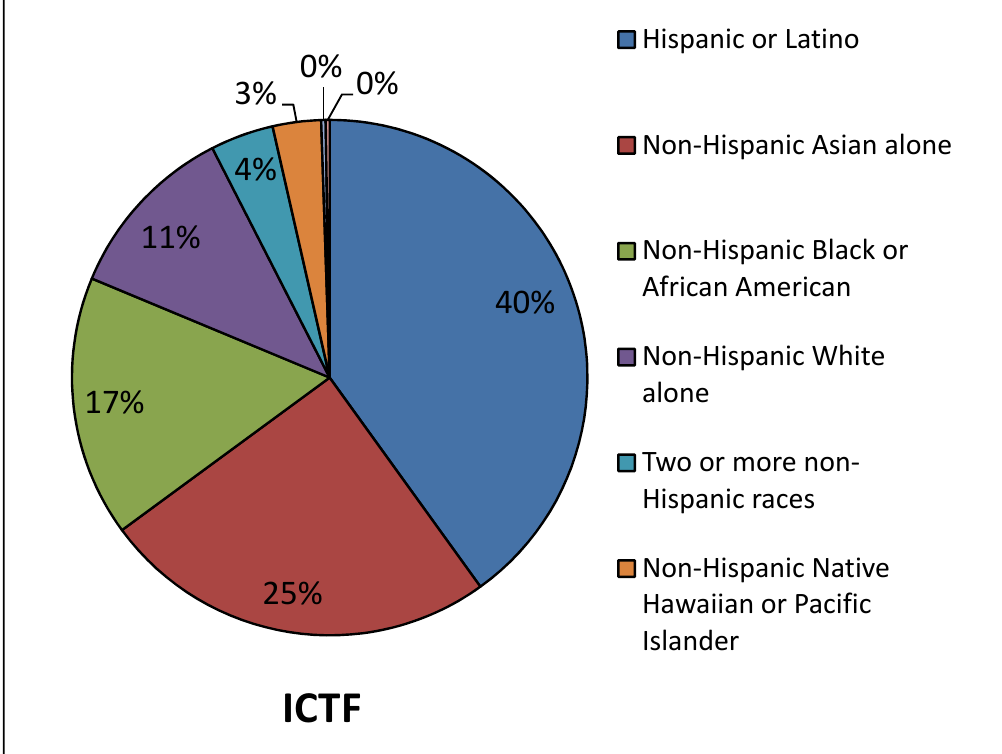
Figure 8. Demographics of the population in west Long Beach in close proximity to the ICTF rail yard, 2000 Census data and in Los Angeles County as a whole at the time that the railroad announced that it wanted to double its capacity; 2000 census